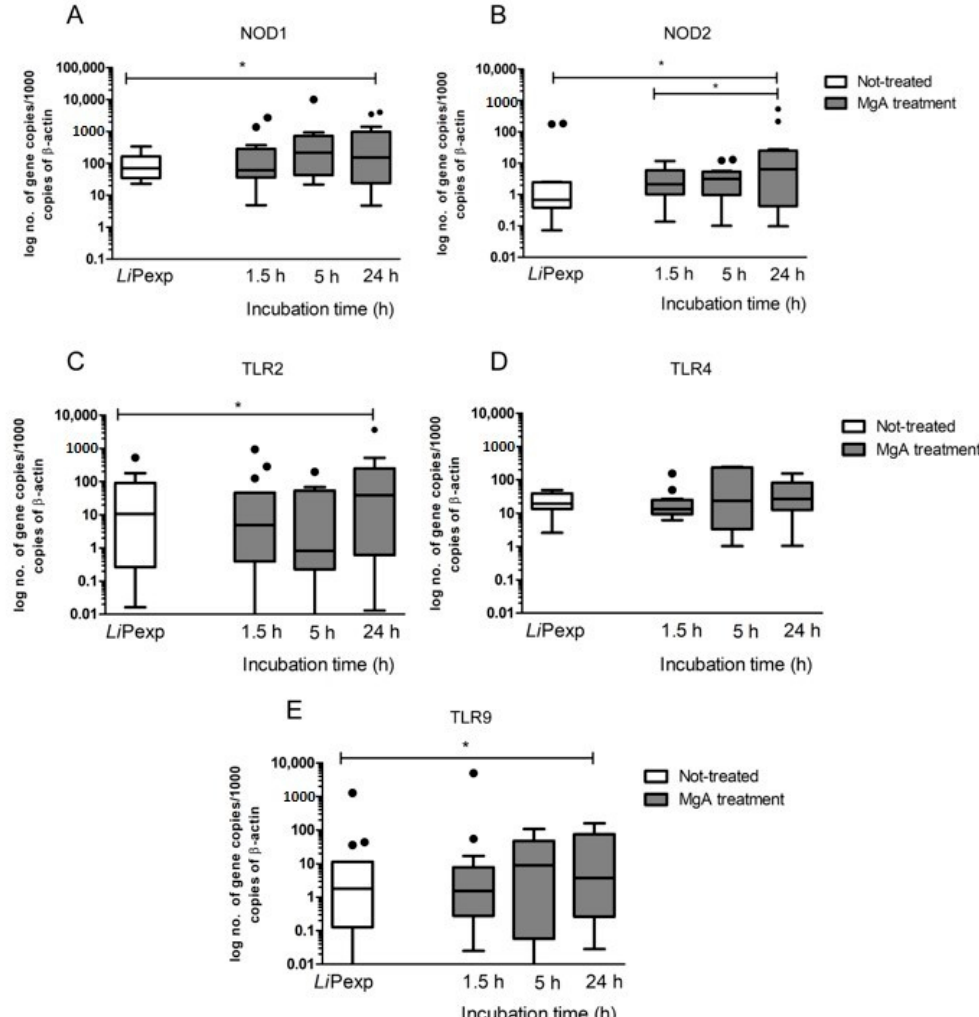
Figure 8. Gene Expression of innate immune receptors after MgA treatment of promastigote-exposed spheroids. Samples of 3D-hepatocytes treated with MgA were collected to evaluate NOD1 ( A ), NOD2 ( B ), TLR2 ( C ), TLR4 ( D ), and TLR9 ( E ) mRNA accumulation at 1.5, 5, and 24 h of treatment. Untreated hepatocyte aggregates exposed to parasites for 72 h ( Li Pexp) also were evaluated. Results of 10 dogs performed in triplicate are represented by Tukey graphs. Black dots are indicative of outlier values. The non-parametric Wilcoxon test was used for statistical comparisons, and * indicates statistically significant differences ( p < 0.05).